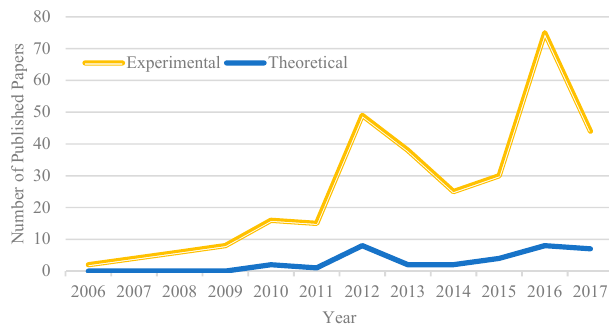
Figure 1. Research on nanotechnology application in the petroleum industry.